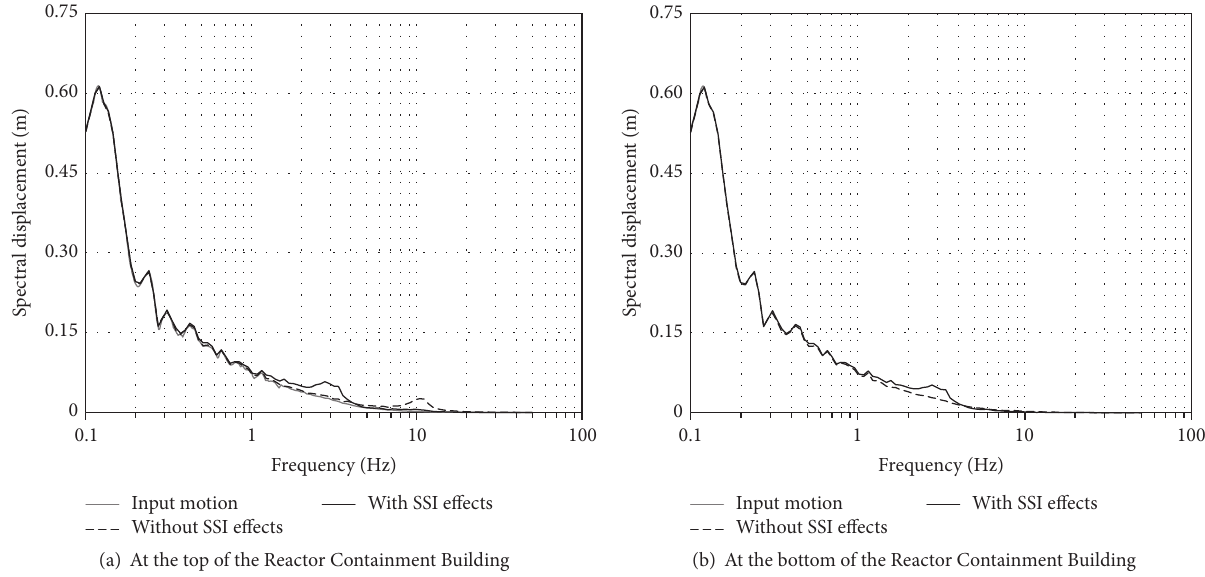
Figure 20: Comparison of the response spectral displacement with and without SSI effects under vertical excitation.